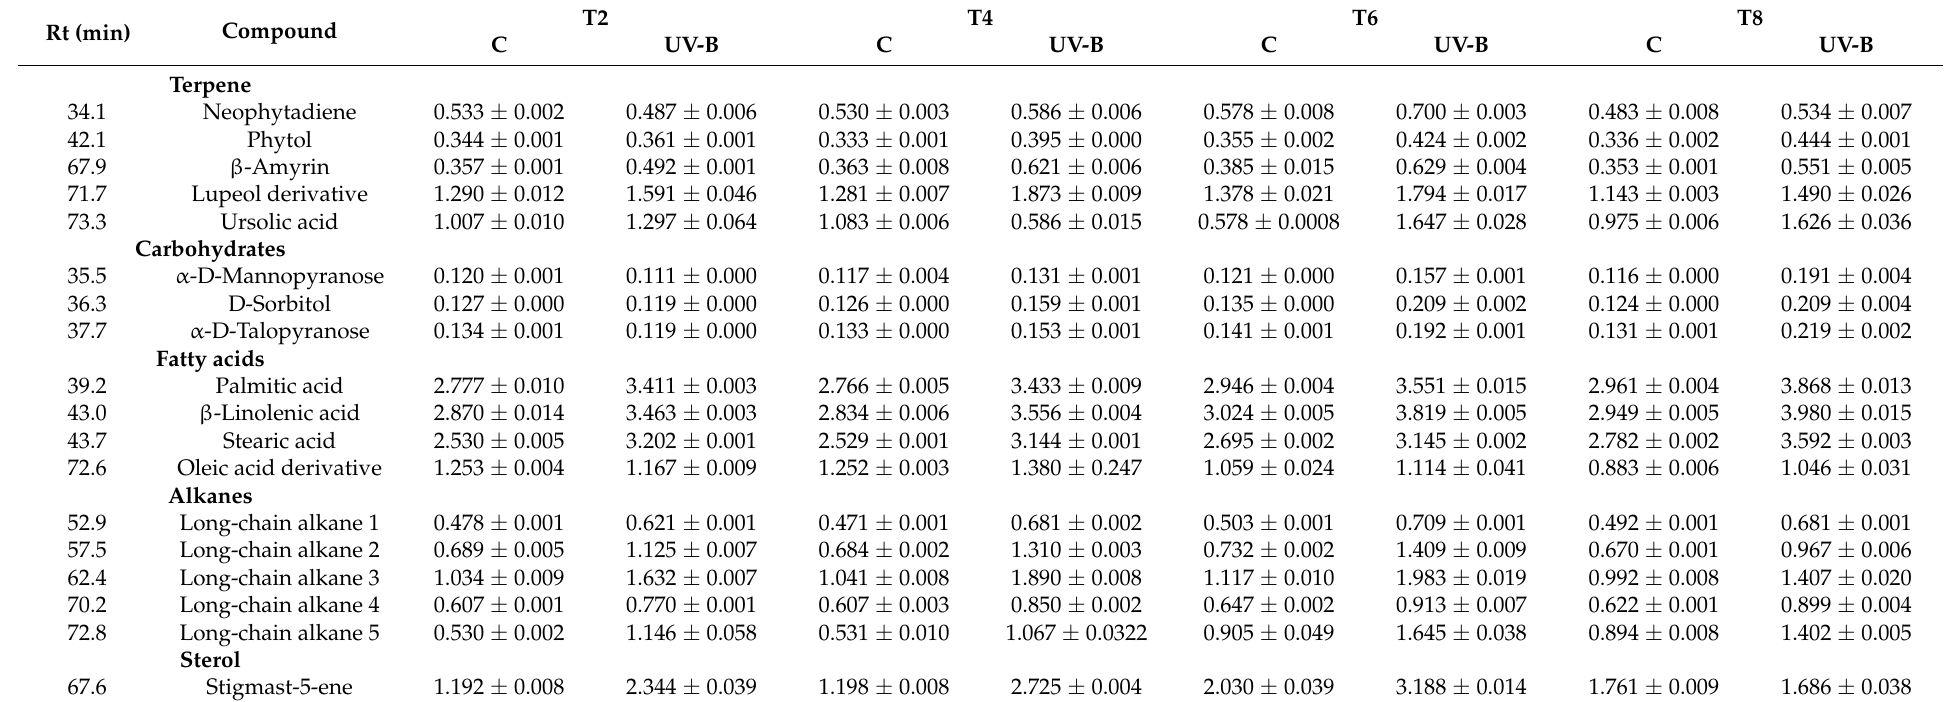
Table 4. Lipophilic profile (g kg − 1 DW) of Olea europaea leaves (Olivastra Seggianese variety) under control (C) and UV-B conditions sampled at the 2nd (T2), 4th (T4), 6th (T6), and 8th (T8) week after the onset of stress. Values are mean ± standard deviation ( n = 3). Rt—Retention time. ANOVA showed that most of chemical components were significantly affected by the main factors and their